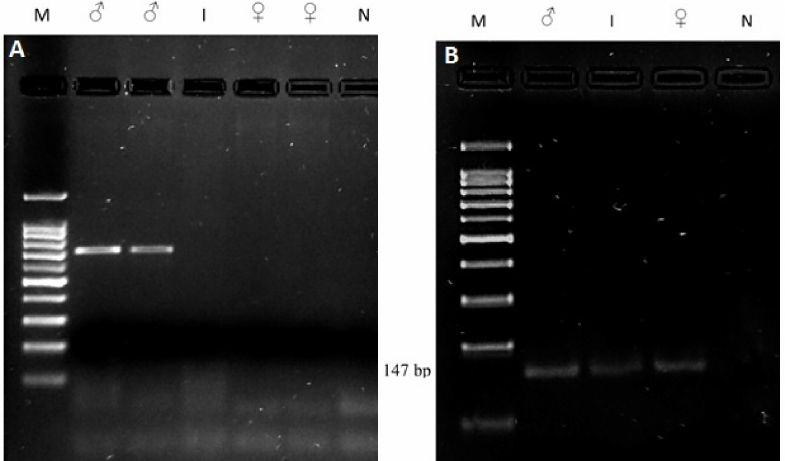
Figure 3. Agarose gel (1.5%) with PCR fragments. (known male roe deer); I (intersex roe deer); ♂ (known female roe deer); and N (negative control (no DNA)). A 5 µ L volume of each PCR product ♀ and 1.5 µ L of loading dye were deposited in each well. M: molecular marker, 100 bp Plus DNA Ladder (C: 304,105 BIORON, Germany) ( A ) SRY gene. A band of ~700 bp was amplified for the control males, and was subsequently sequenced. The control females did not present any amplification. The intersex roe sample did not present any band, indicating the absence of the Y chromosome ( B ) PIS mutation. All of the samples showed amplification of the expected band, thus refuting the presence of PIS